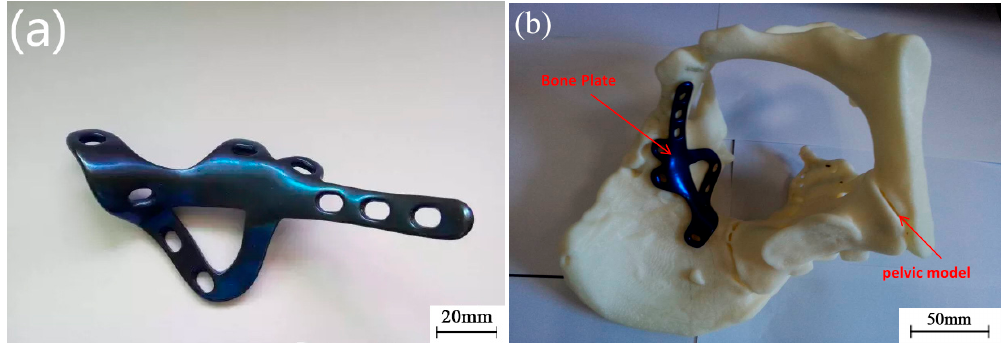
Figure 7. Surface treatment and pre-operative simulation: ( a ) Customized bone plate after surface post-treatment; and ( b ) The match between bone plate and pelvic model.